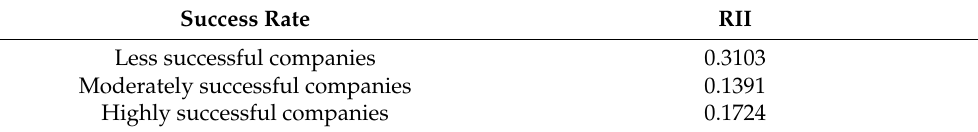
Table 1. Influence of estimated value of procurement on bid price assessment. Success Rate RII Less successful